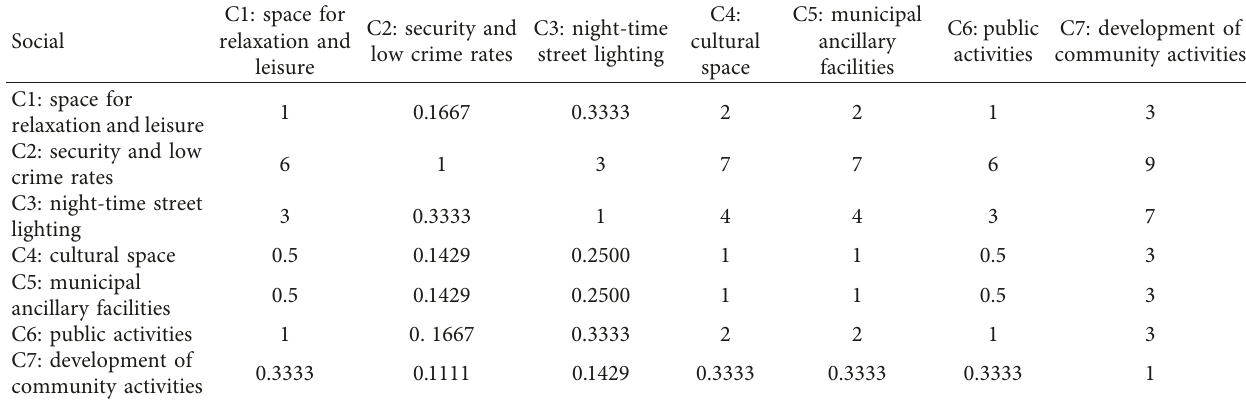
Table 5: Matrix of social criteria.